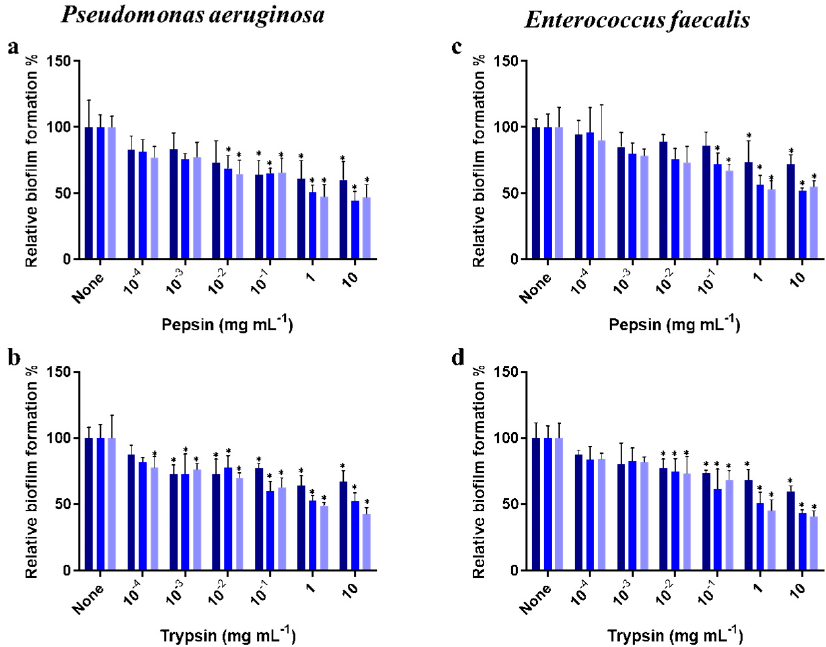
Figure 3. Dispersal of established P. aeruginosa ( a , b ) and E. faecalis ( c , d ) biofilms by pepsin and trypsin using different concentrations (10 − 4 –10 mg mL − 1 ) and different times of action (30 min − 1 h − 2 h). Biofilm dispersion was studied in 96-well polystyrene plates at 37 °C. Total biofilm formation was measured at OD600. Results are presented as the means (±SD) of three independent experiments. * p < 0.05 indicates a significant difference compared with control using Tukey’s test.